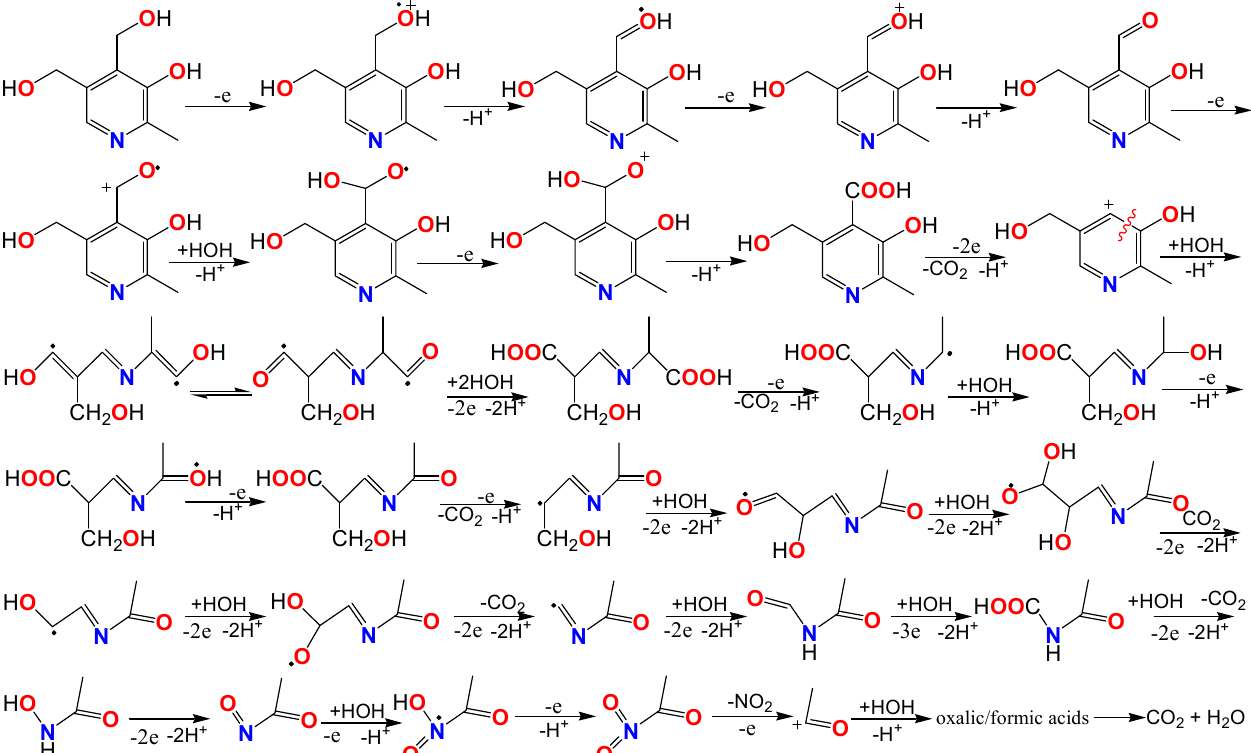
Scheme 1. The mechanism of electrochemical degradation of pyridoxine by a direct